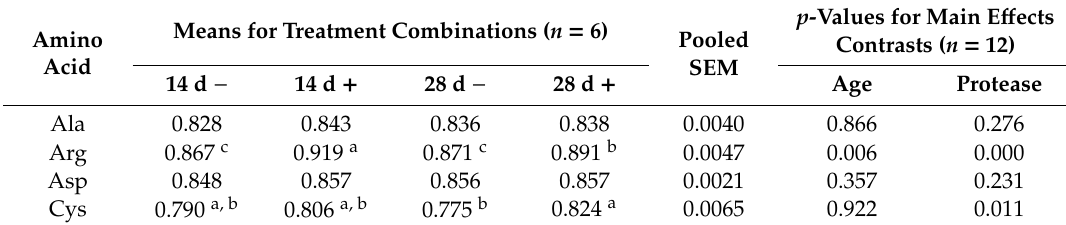
Table 6. Standardised ileal digestibility of amino acids in the seeds of the white-flowered pea cv. Tarchalska as a ff ected by chicken age (14 or 28 d) and supplementation of assay diet with protease. Means for Treatment Combinations ( n = 6) Pooled Amino Acid